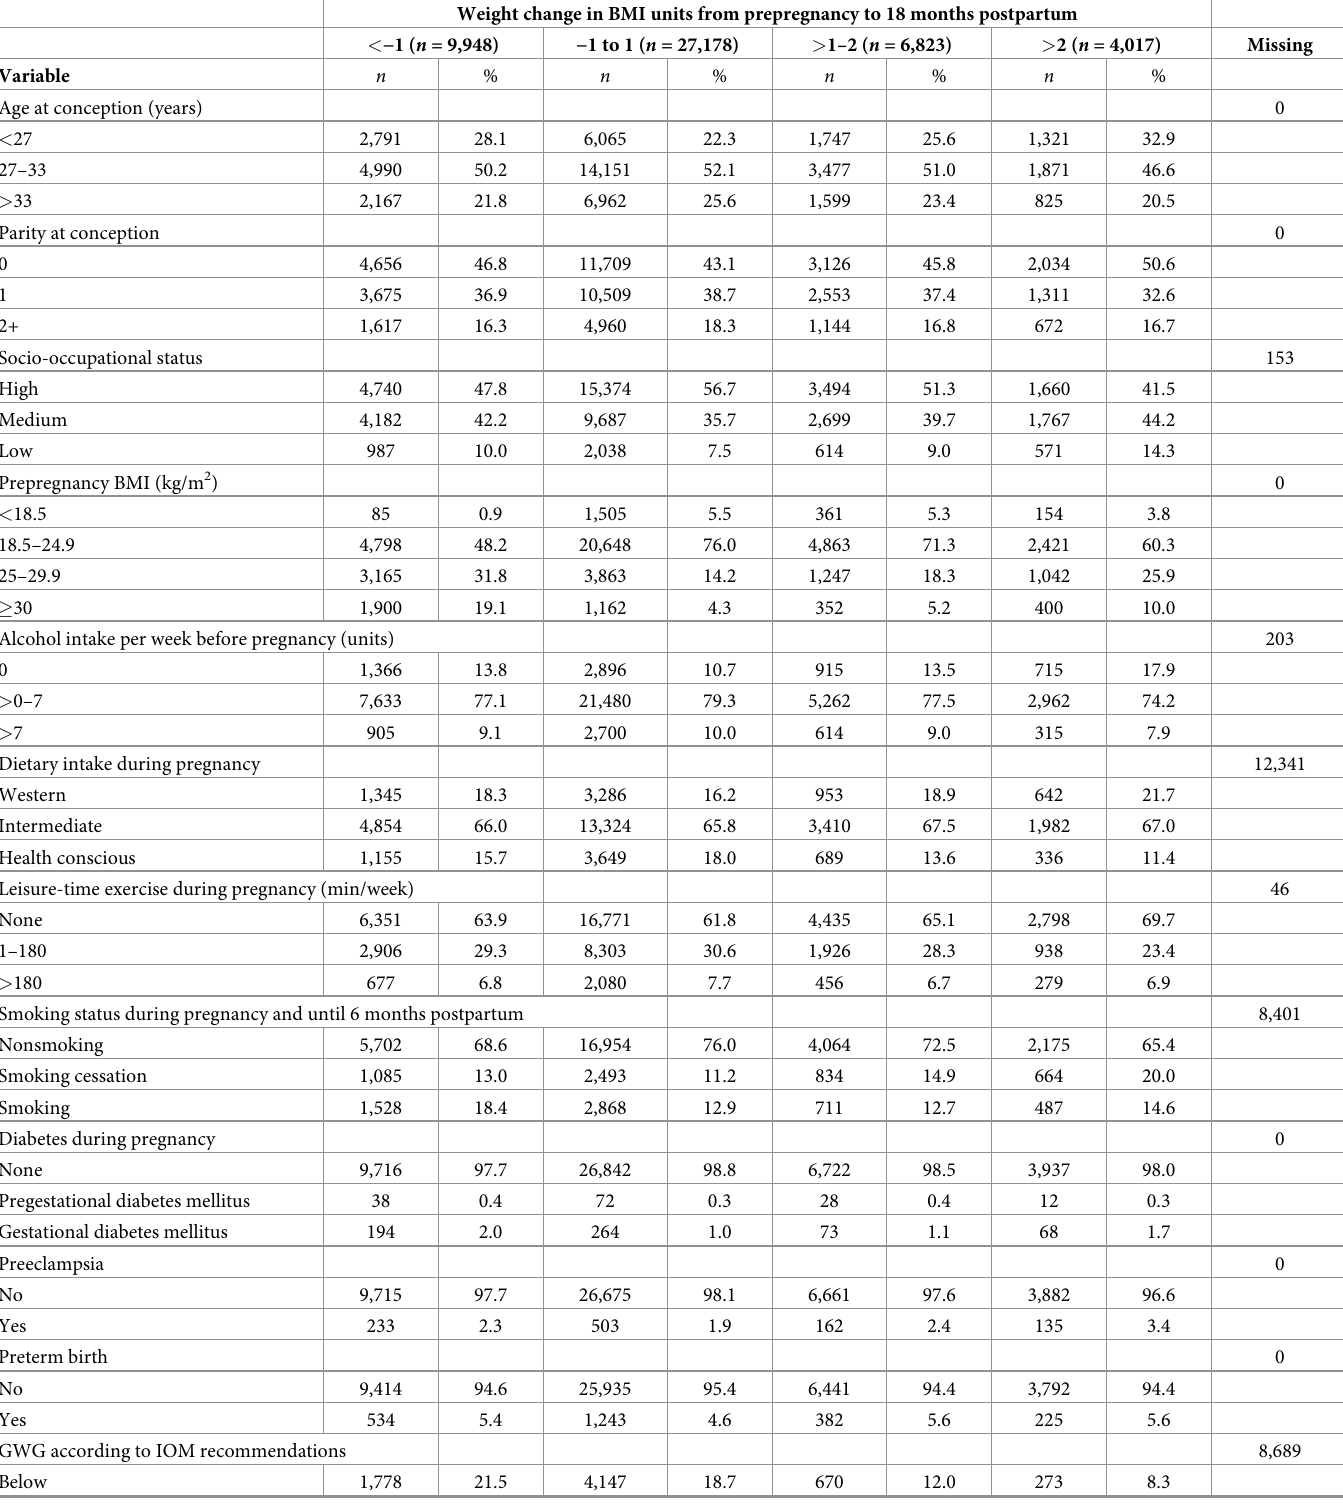
Table 1. Maternal characteristics according to weight change from prepregnancy to 18 months postpartum within 47,966 women participating in the